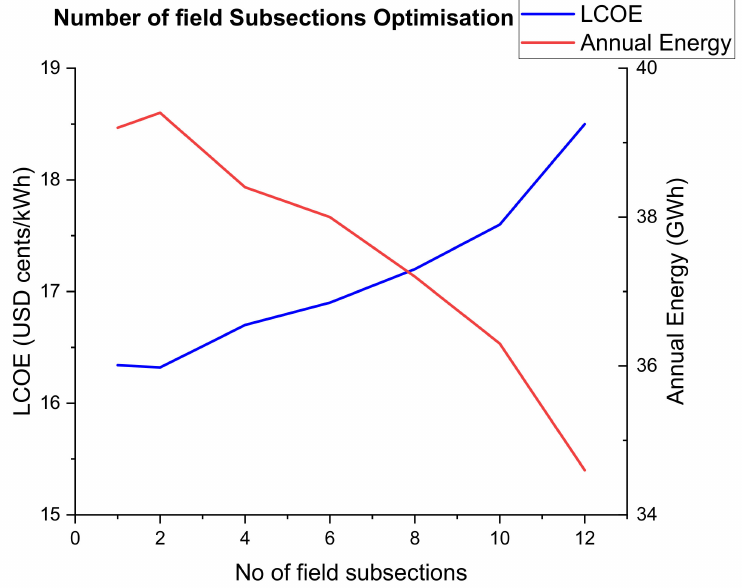
Figure 21. Optimisation of the number of field